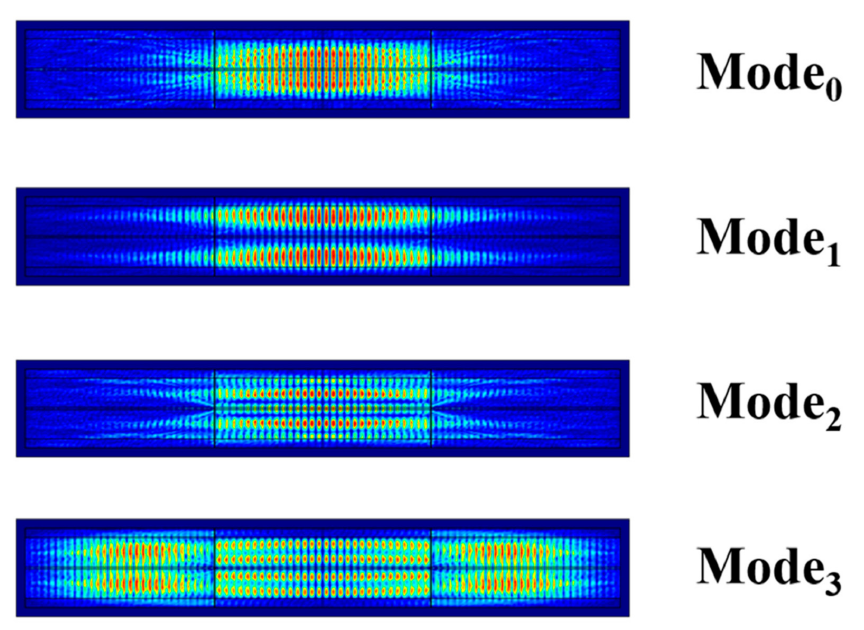
Figure 5. Transverse modes of order 1~4.